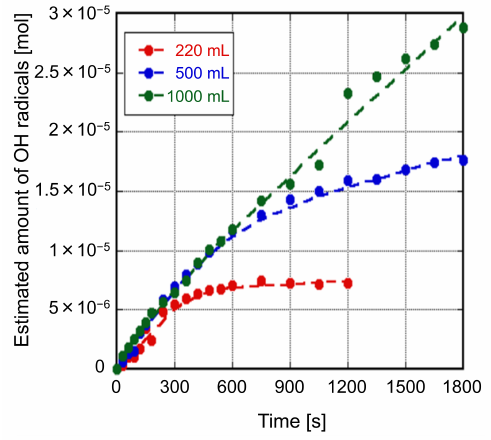
Figure 7. Estimated amount of OH radicals in the solution as a function of time with various volumes of 2 mM NaTA solution. Pulsed streamer discharges with a peak value and repetition frequency of 24 kV and 100 pps were irradiated to the 2 mM NaTA solution, which was circulated with a flow rate of 600